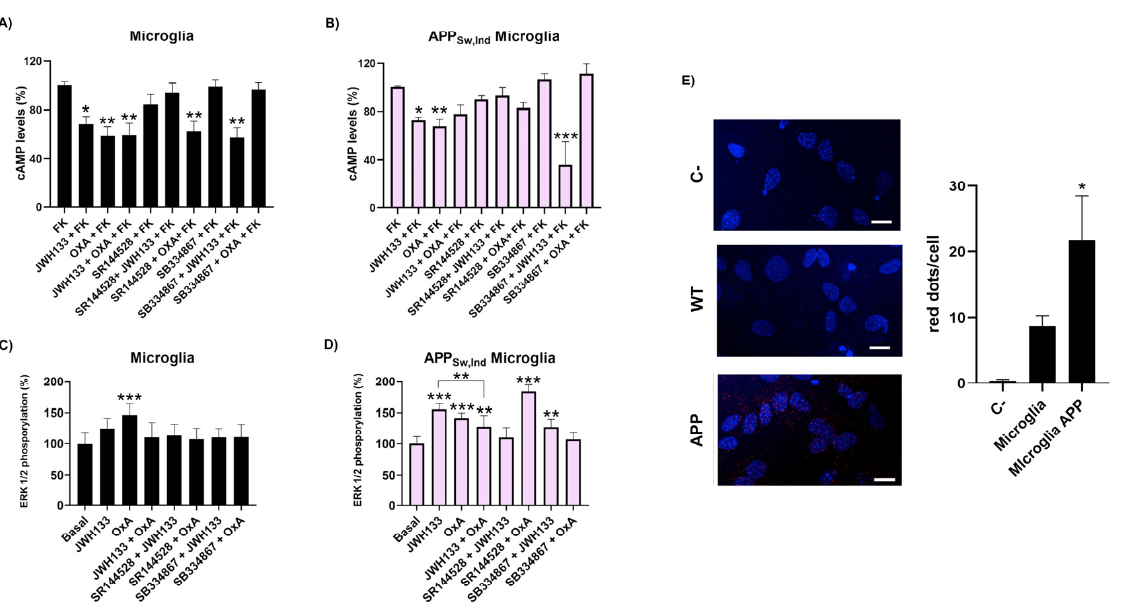
Figure 4. Functionality of CB 2 R and OX 1 R heteromer in the microglia from the APP Sw,Ind mouse. Primary microglia from APP Sw,ind ( A , B ) or age-matched control animals ( B , D ) were pre-treated with selective receptor antagonists (1 µ M SR144528 for CB 2 or 1 µ M SB334867 for OX 1 receptors) for 15 min and subsequently treated with selective agonists (100 nM JWH133 for CB 2 or 100 nM orexin- A for OX 1 receptors) in single or combined treatments. cAMP levels ( A , B ) were detected 15 min after forskolin addition. Values are the mean ± S.E.M. of seven different experiments performed in triplicates. One-way ANOVA followed by Bonferroni’s multiple comparison post hoc test was used for statistical analysis (* p < 0.05 versus forskolin treatment). ( C , D ) ERK1/2 phosphorylation was analyzed using an AlphaScreen ® SureFire ® kit (Perkin Elmer). Values are the mean ± S.E.M. of five different experiments performed in triplicates. One-way ANOVA followed by Bonferroni’s multiple comparison post hoc test were used for statistical analysis ( ** p < 0.01, *** p < 0.001ersus untreated cells). ( E ) A proximity ligation assay (PLA) was performed in primary microglia from APP Sw,Ind transgenic mice or age-matched controls, using specific primary antibodies against CB 2 R or against OX 1 R (1/100). Representative images corresponding to stacks of four sequential planes are shown. Cell nuclei were stained with Hoechst (blue) and receptor complexes appear as red dots. The number of red dots/cell was quantified using Andy’s algorithm Fiji’s plug-in (see Section 4). Scale bar: 15 µ M. Values are the mean ± S.E.M. of five different experiments performed in duplicates. One- way ANOVA and Bonferroni’s multiple comparison post hoc test were used for statistical analysis (* p < 0.05 versus